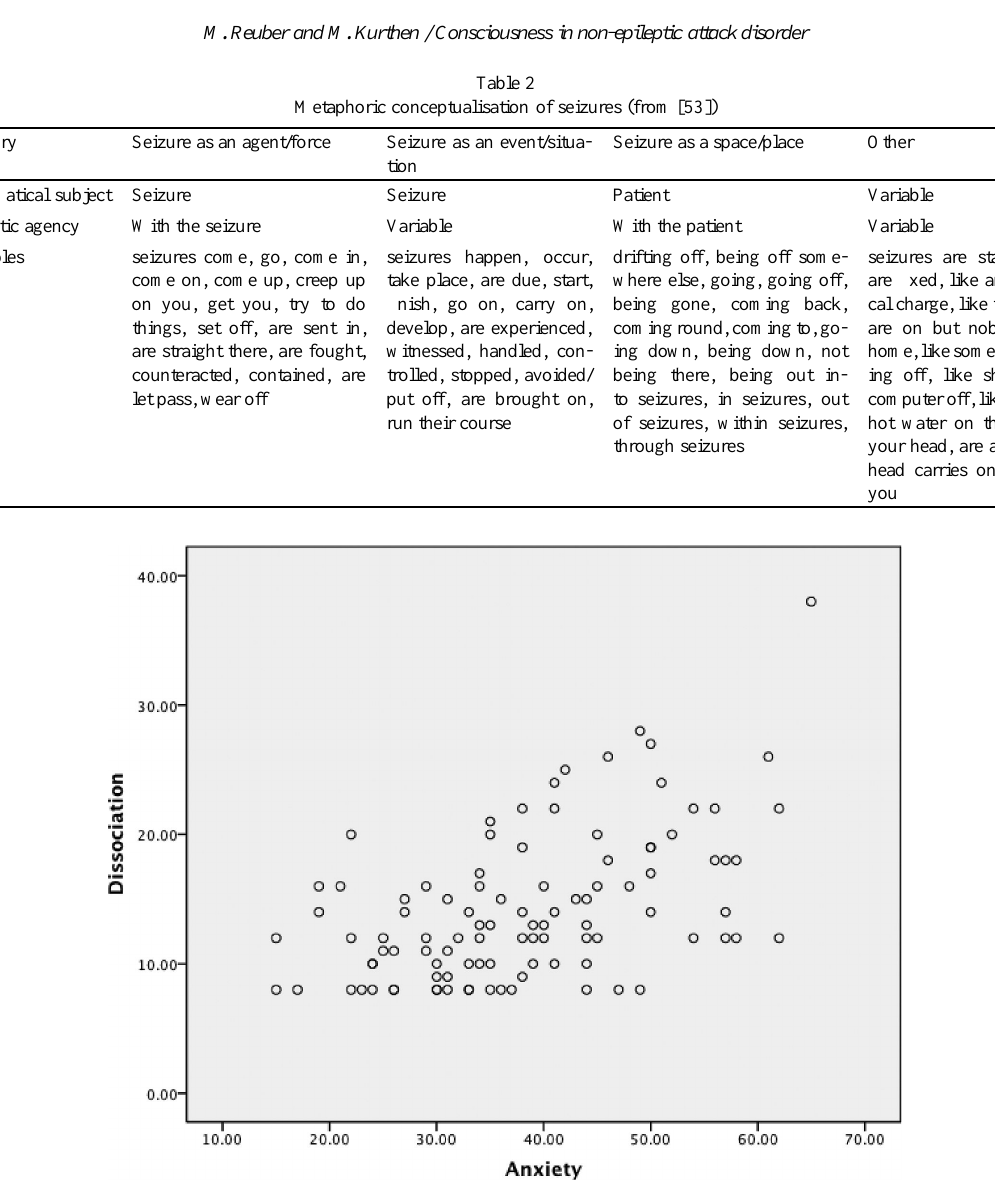
Fig. 3. Positive correlation of the number of ictal symptoms of anxiety and dissociation reported by 100 patients with NEAs ( r = 0.514, p < 0.001).